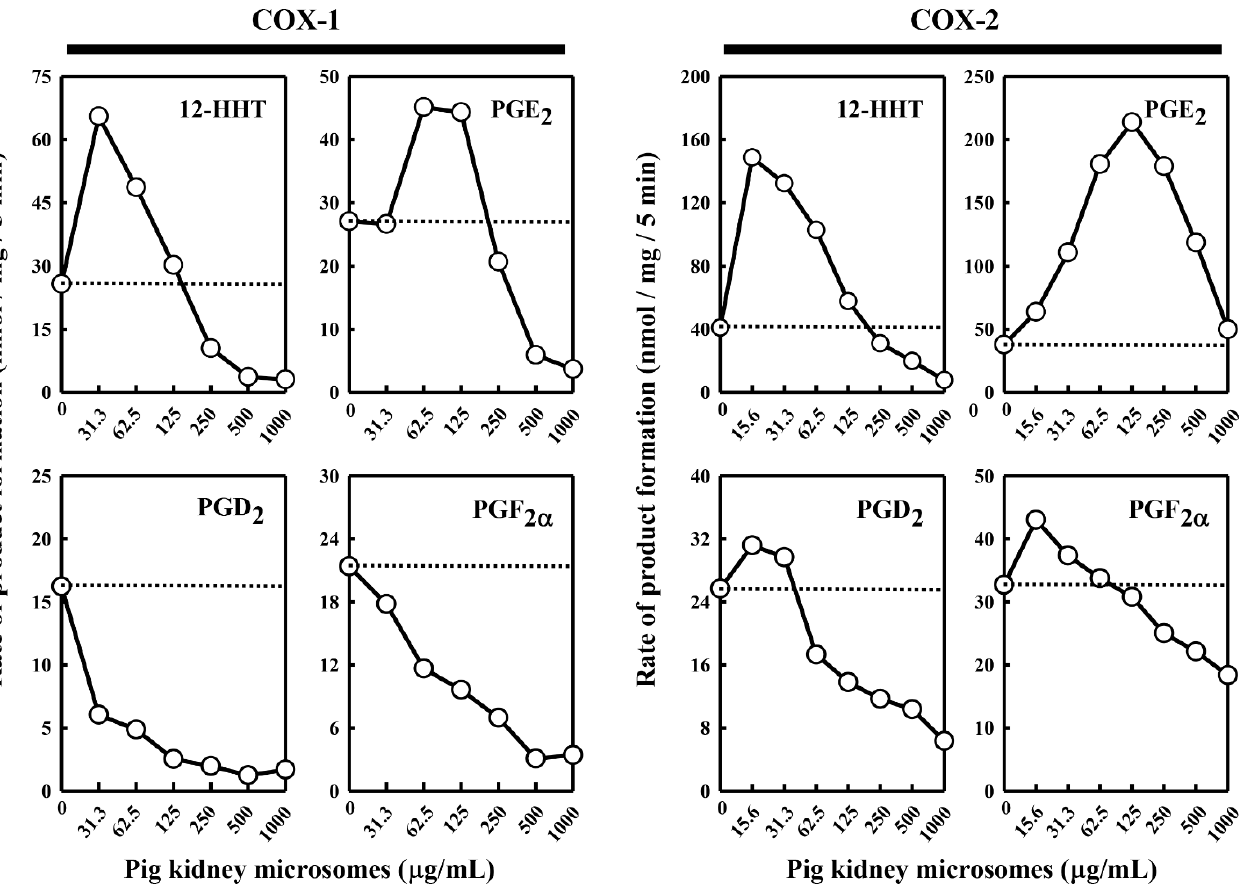
Figure 1. Effect of the pig kidney microsomes on COX-1 and COX-2-mediated conversion of [14C]AA to major PG products. The incubation mixture consisted of seven different concentrations (0, 31.3, 62.5, 125, 250, 500 and 1000 μ g protein/mL) of the pig kidney microsomes, 20 μ M [14C]AA (0.2 μ Ci) as substrate, 0.5 μ g/mL COX-1 or 0.97 μ g/mL COX- 2 as the enzyme, 10 mM EDTA, 1 mM reduced glutathione, and 1 μ M hematin in 200 μ L of 100 mM Tris-HCl buffer, pH 7.4. The incubations were carried out at 37 °C for 5 min. The dotted line shows the control catalytic activity of COX-1 or COX-2 in the absence of the pig kidney microsomes. Each value is the mean of duplicate measurements, with small replicate variations (usually well below